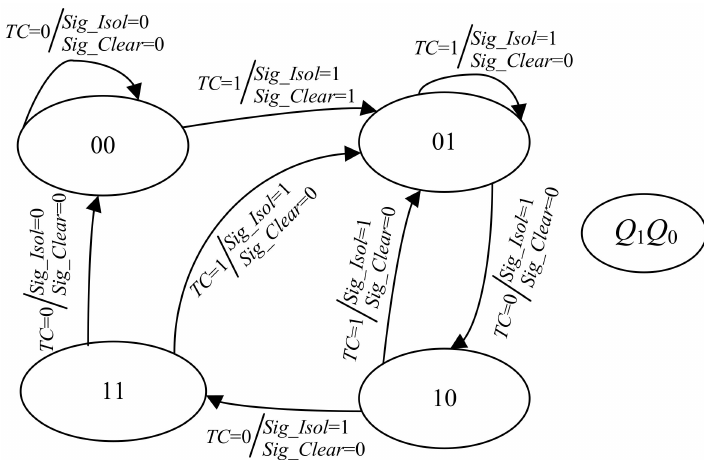
Figure 5. The actual state